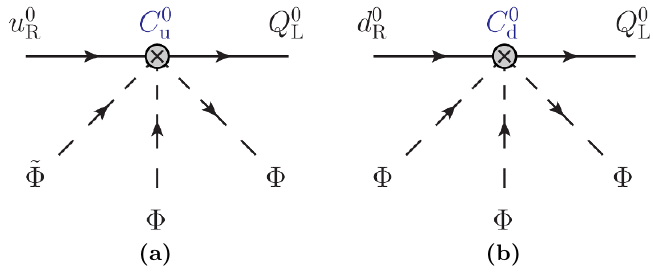
Figure 1 . Yukawa operators in eqs. (2.5) and